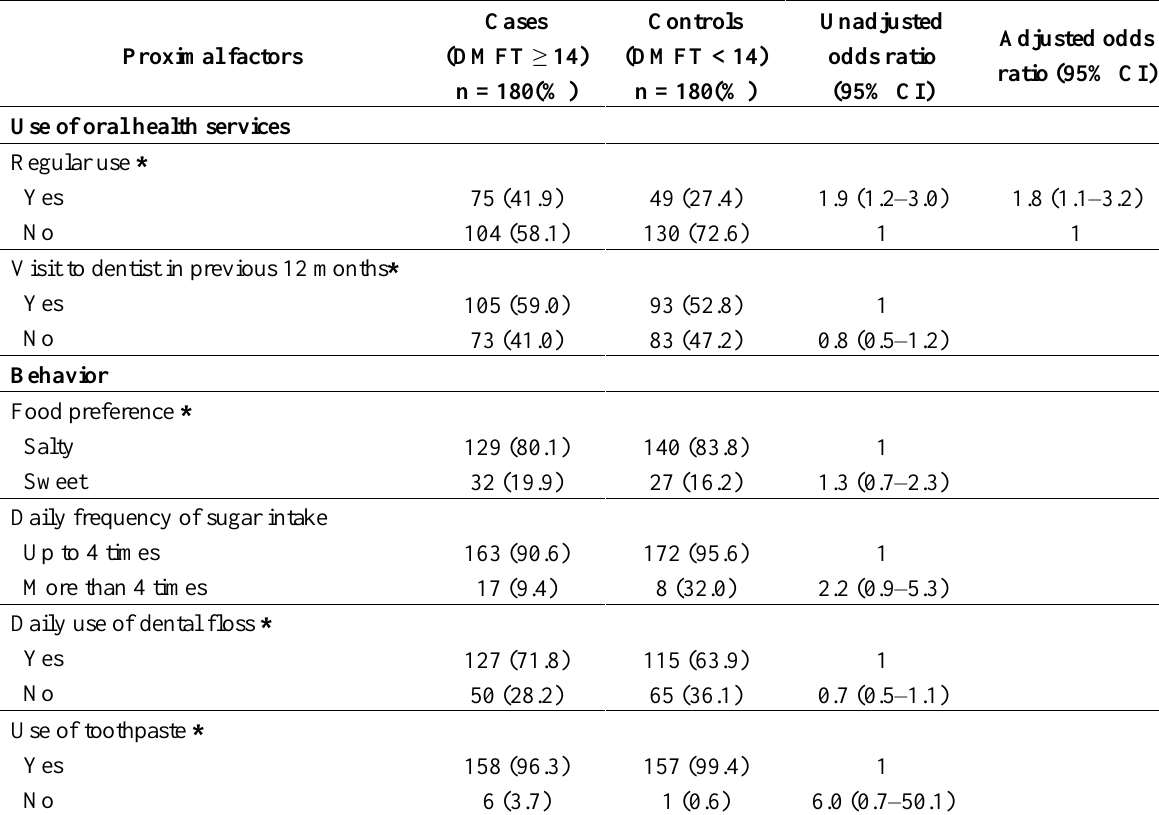
Table 2. Proximal factors associated with high dental caries in adults, Brazil,